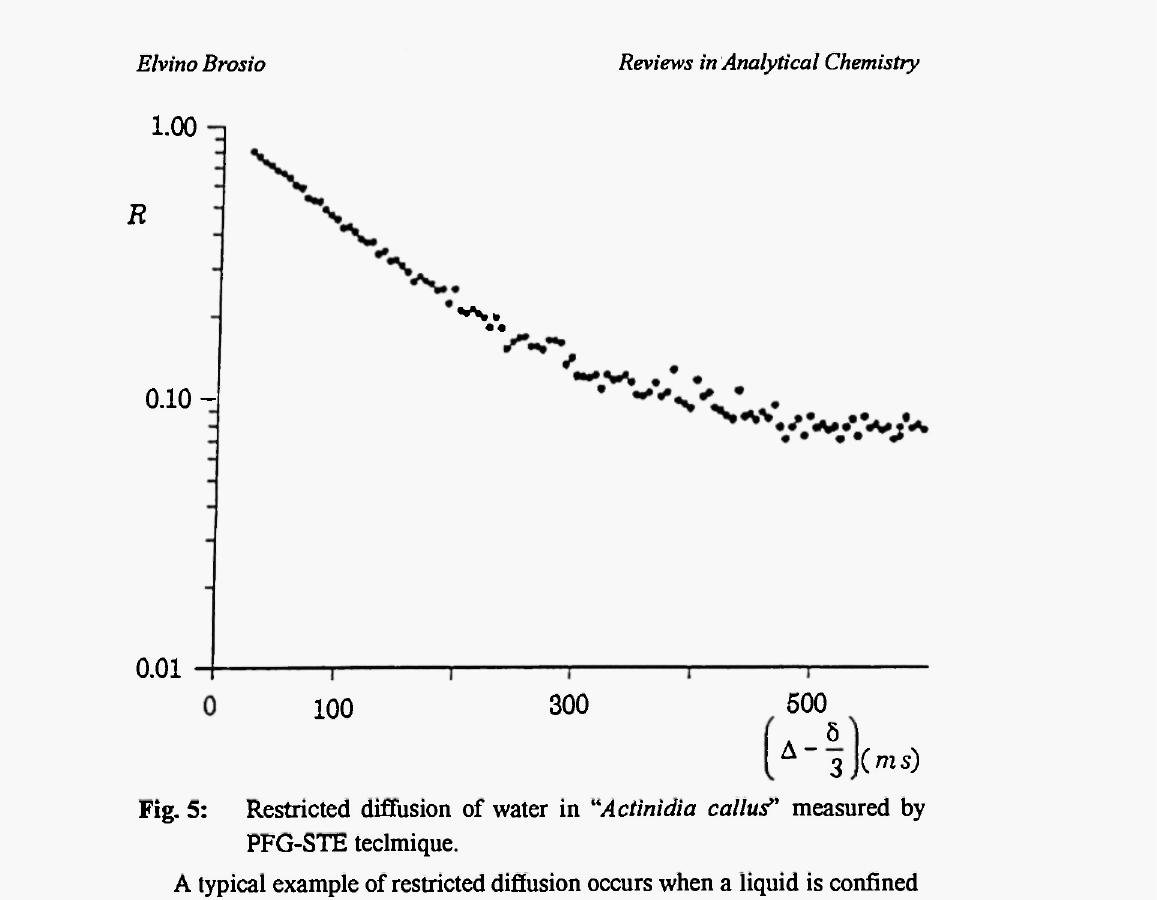
Fig. 5: Restricted diffusion of water in " Actinidia callus" measured by PFG-STE